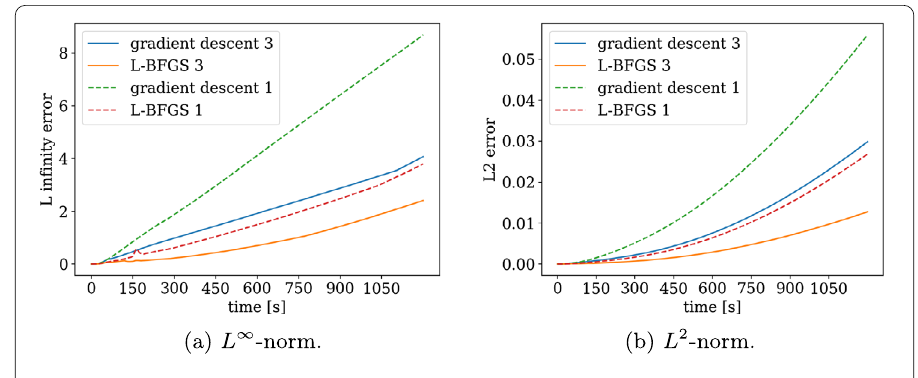
Figure 7 Evolution of the error in temperature over time for 3